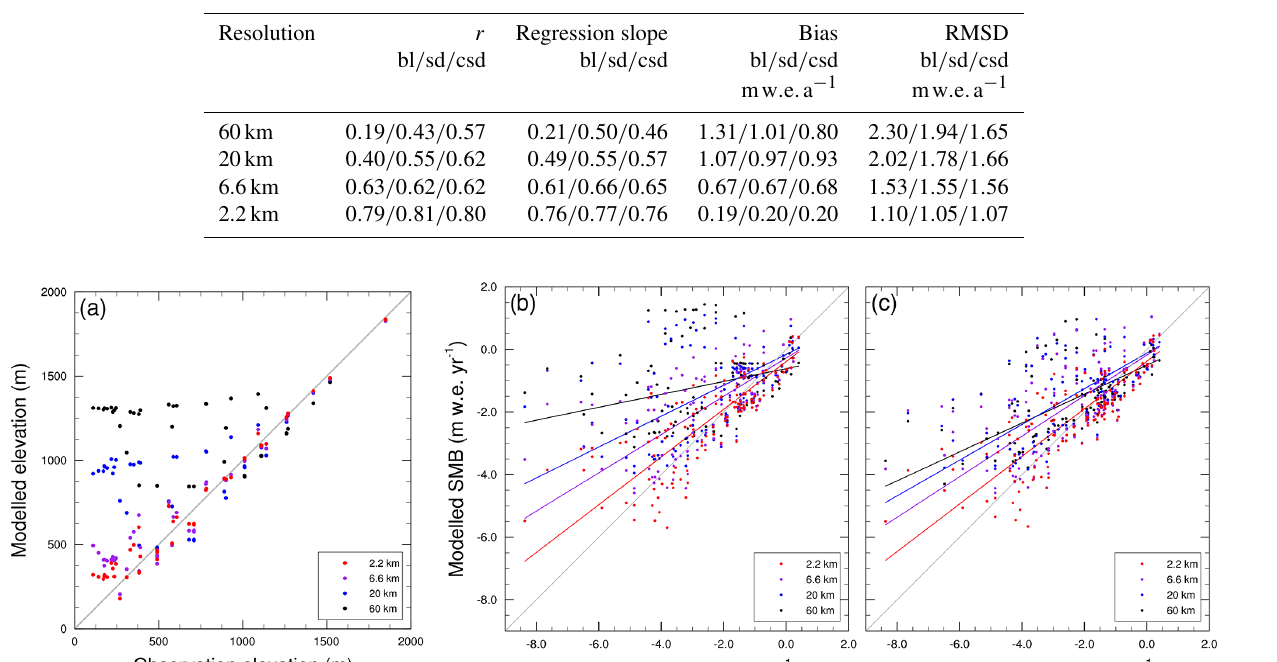
Table 4. Correlation, orthogonal regression slope, bias, and RMSD for bilinear (bl), statistically downscaled (sd), and component-wise statistically downscaled (csd) SMB to the location of the observation, respectively.